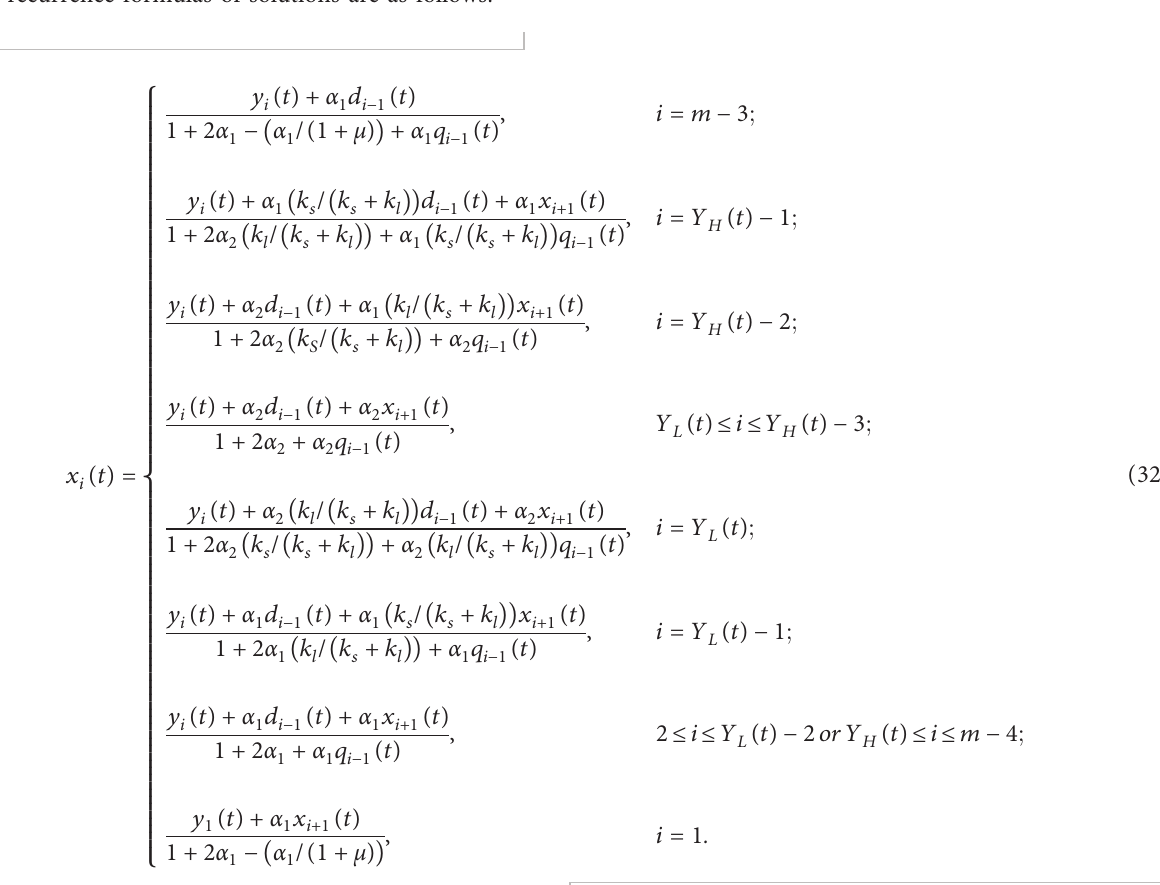
experimental measurement. Figure 6(b) indicates the rela- tive errors between the numerical results and